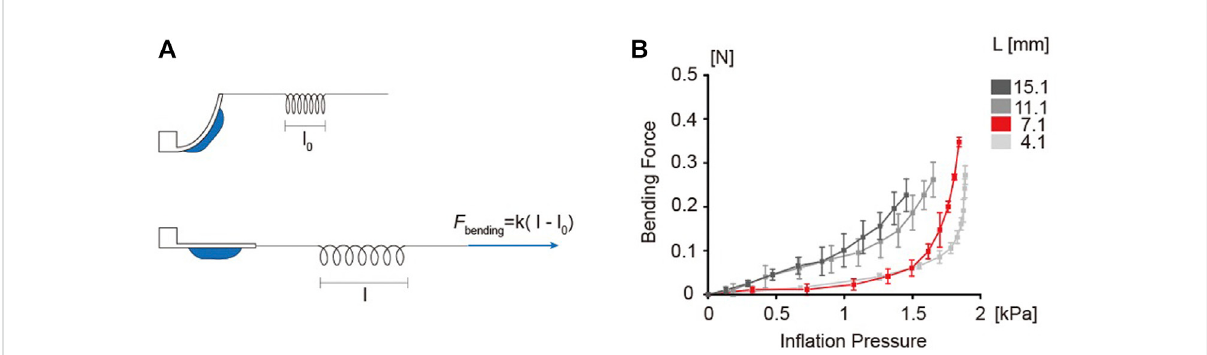
FIGURE 6 Experimental setup for bending force measurement. (A) Illustration of force measurement method using a rubber band. The rubber band is described as a spring in the fi gure. The rubber band was pulled to estimate the bending force until the fl exible body became parallel with the pulling direction. (B) Bending force curves as a function of in fl ation pressure. 4.1, 7.1, 11.1 and 15.1 mm chamber lengths were